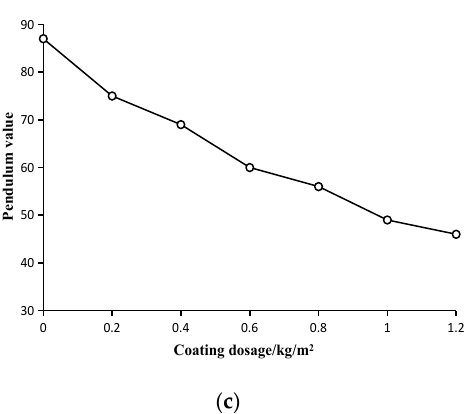
Figure 17. Effect of the coating on pavement performance of the mixture: ( a ) Adhesion strength between coating and pavement; ( b ) Effect of coating on seepage performance of the mixture; ( c ) Effect of the coating on the skid resistance of the mixture